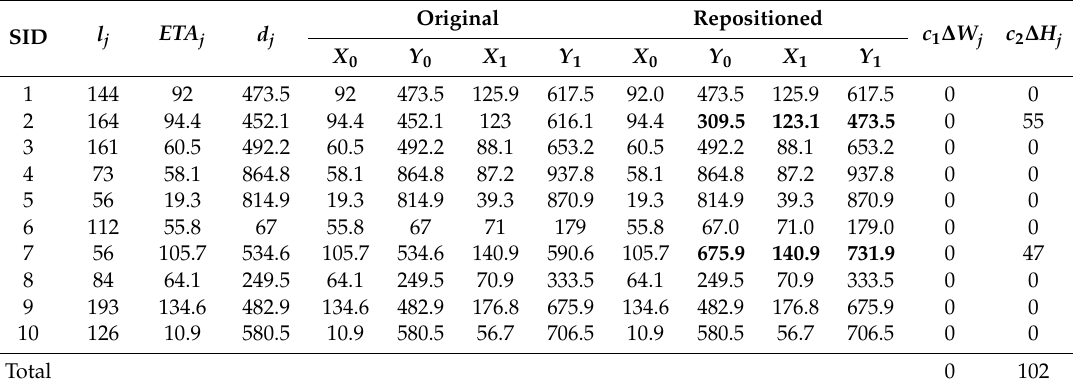
Table 2. Original and repositioning ship data after resolving overlaps ( N = 10).